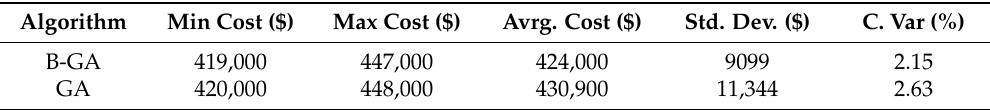
Table 4. Solutions found by both algorithms for the Alperovits and Shamir network.